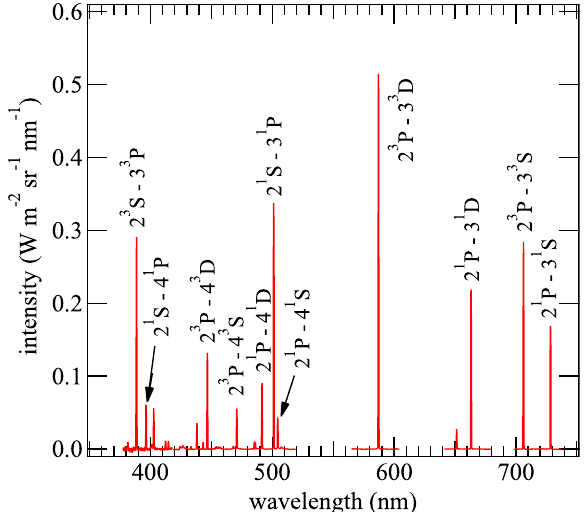
Figure 1. A spectrum consisting of seven fractional spectra recorded at different wavelengths. They were measured on a viewing chord at a distance of 15 mm from the z -axis and z = 20